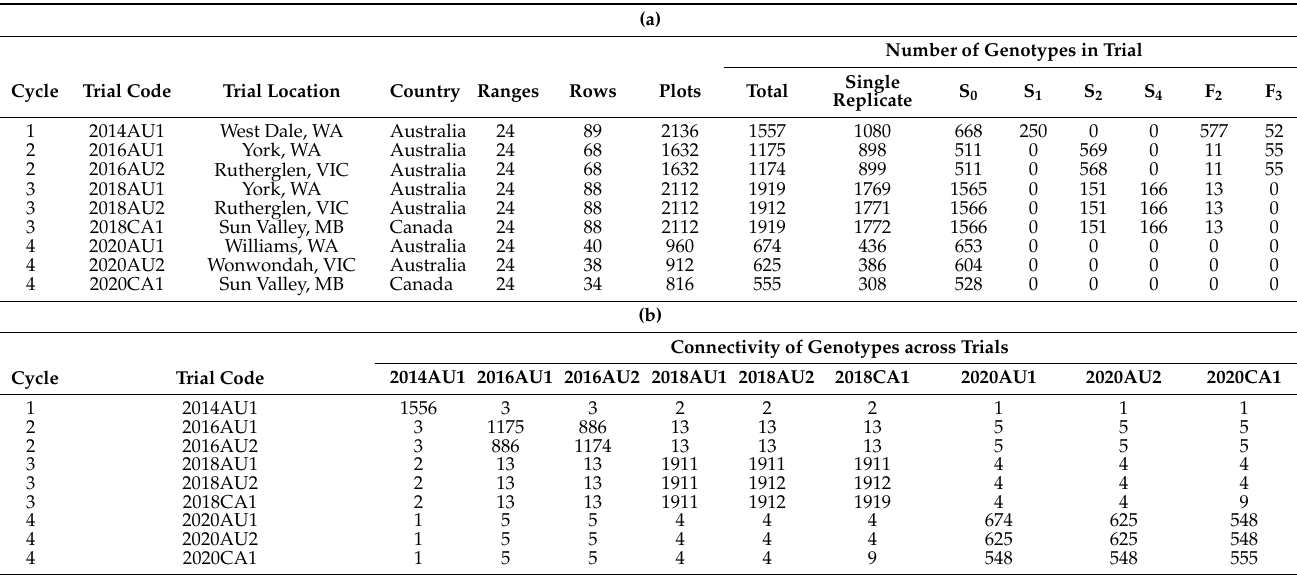
Table 1. ( a ) Cycle number, trial code, trial location and country of each trial site, the number of plots, ranges, rows, genotypes (including number tested in a single replicate) in each trial, and ( b ) connectivity of genotypes across trials in the study. Genotypes defined as S 0 were tested in field trials as S 0,1 bulks; likewise F 2 genotypes were tested as F 2,3 bulks, S 2 genotypes were tested as S 2,3 bulks, and so on. State abbreviations (Australia): Western Australia (WA), Victoria (VIC). Province abbreviation (Canada): Manitoba (MB). (a) Number of Genotypes in Trial